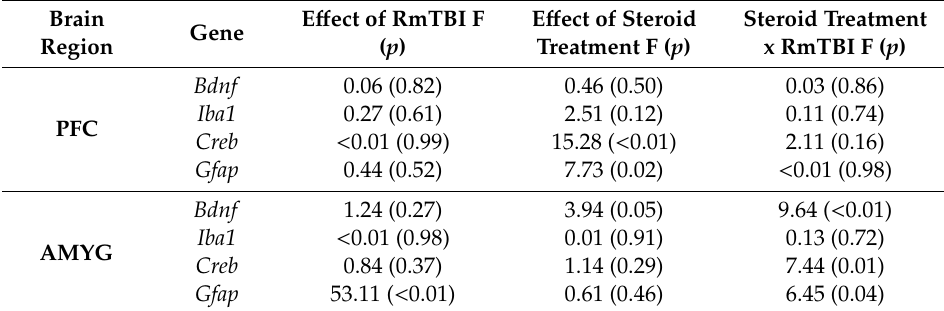
Table 3. Statistical results of the 2-way ANOVAs for the changes in mRNA expression following RmTBI and steroid